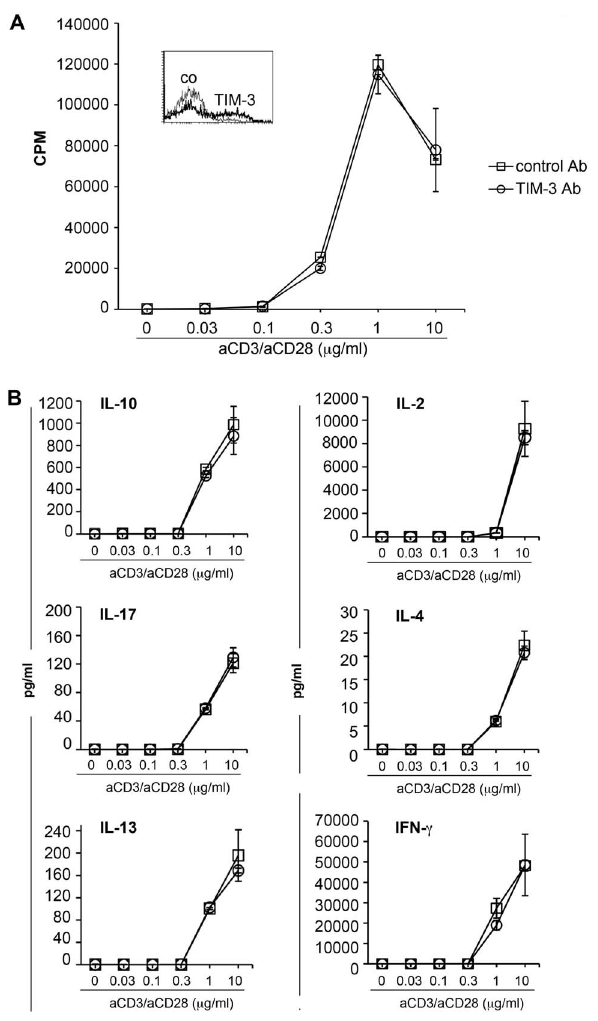
Figure 3. TIM-3 antibodies do not affect human T cell activation. CD4 T cells were stimulated with plate-bound antibodies to CD3 and CD28 immobilized at the indicated concentration. The expression of TIM-3 (bold line; isotype control: thin line) following activation is shown (inset). TIM-3 antibody (clone 2E2) or control antibody (both at a final concentration of 10 m g/ml) were added to the cultures and following 48 h of stimulation, culture supernatants were harvested and methyl- 3 [H]-thymidine was added to the cultures. A) Upon 18 h of additional culturing, cells were harvested and methyl- 3 [H]- thymidine uptake was measured to assess T cell proliferation. B) The cytokine concentration in the supernatants was measured using a Luminex-based multiplex assay. The results of triplicate measurement of one experiment representative for four experiments are shown.